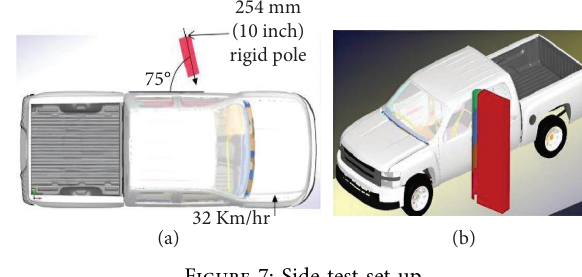
Figure 7: Side test set up.